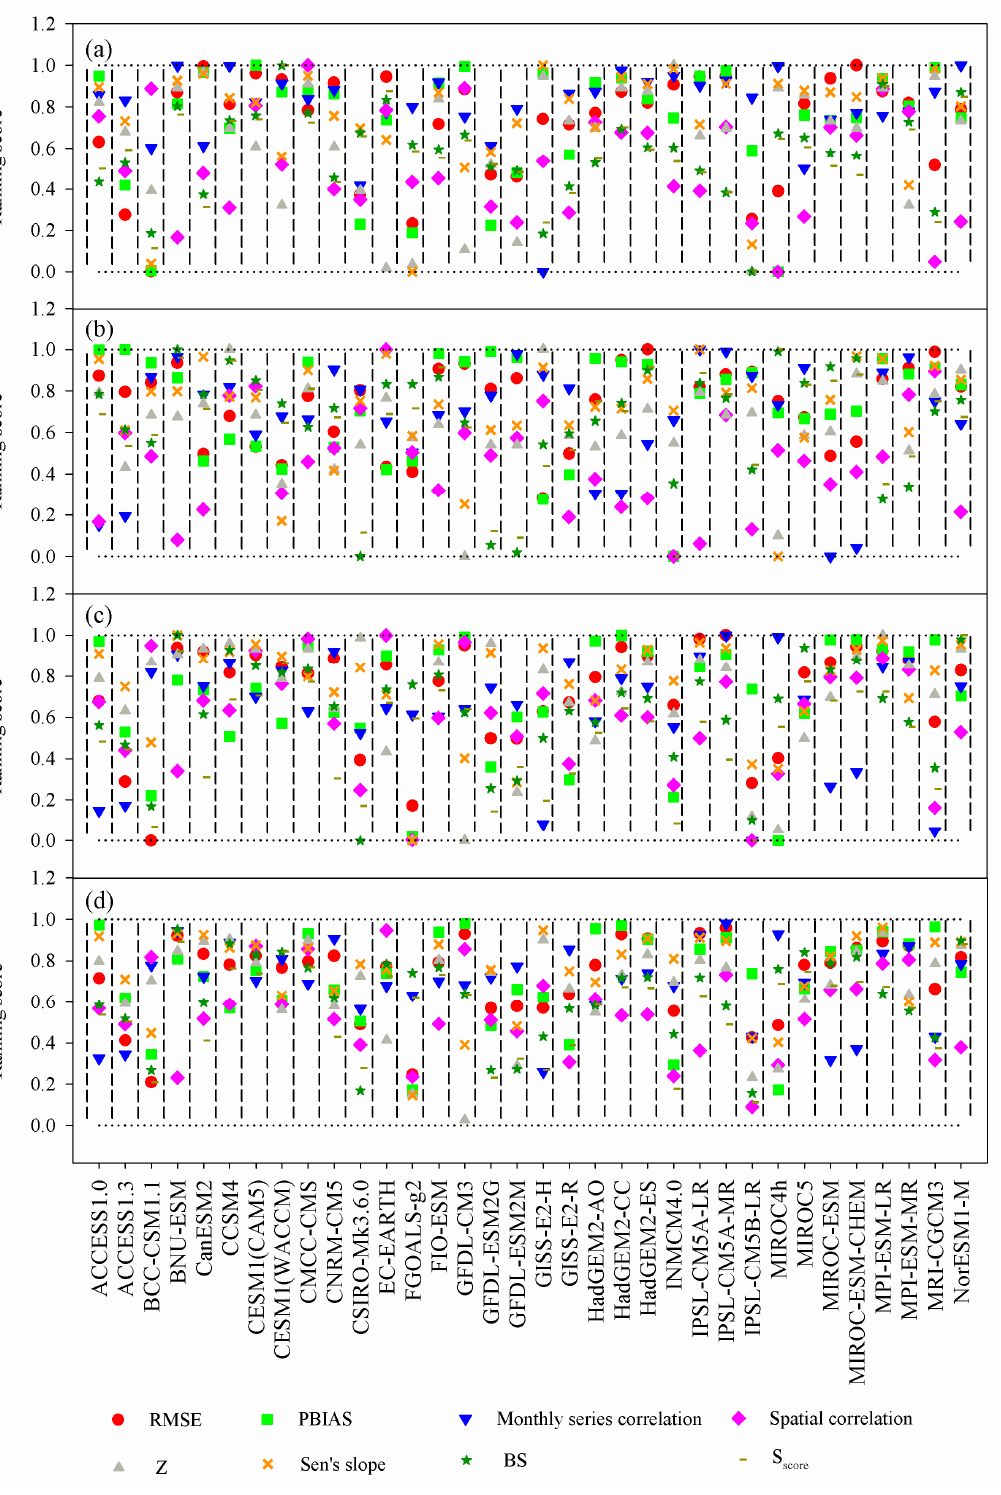
Figure 7. Ranking scores of the eight criteria over the LMB: ( a ), ( b ), ( c ), and ( d ) represent the wet season, dry season, annual time, and the overall results, respectively.